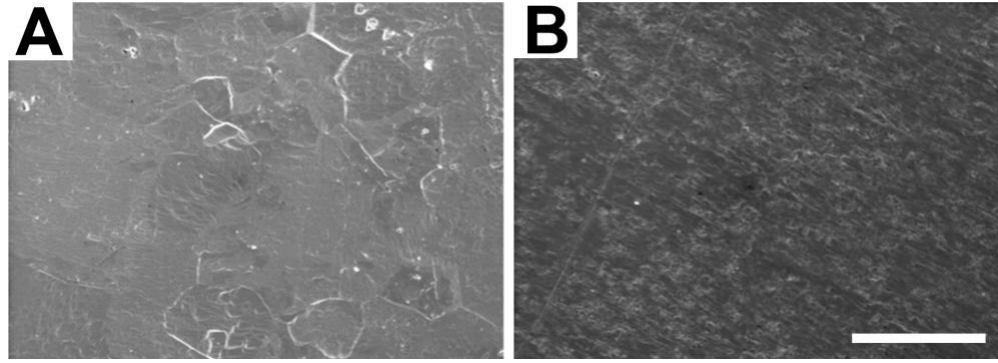
Figure 3. Examples of high power SEM images from the surface of titanium platelets that were either etched ( A ), or not etched ( B ). The white bar represents a length of 50